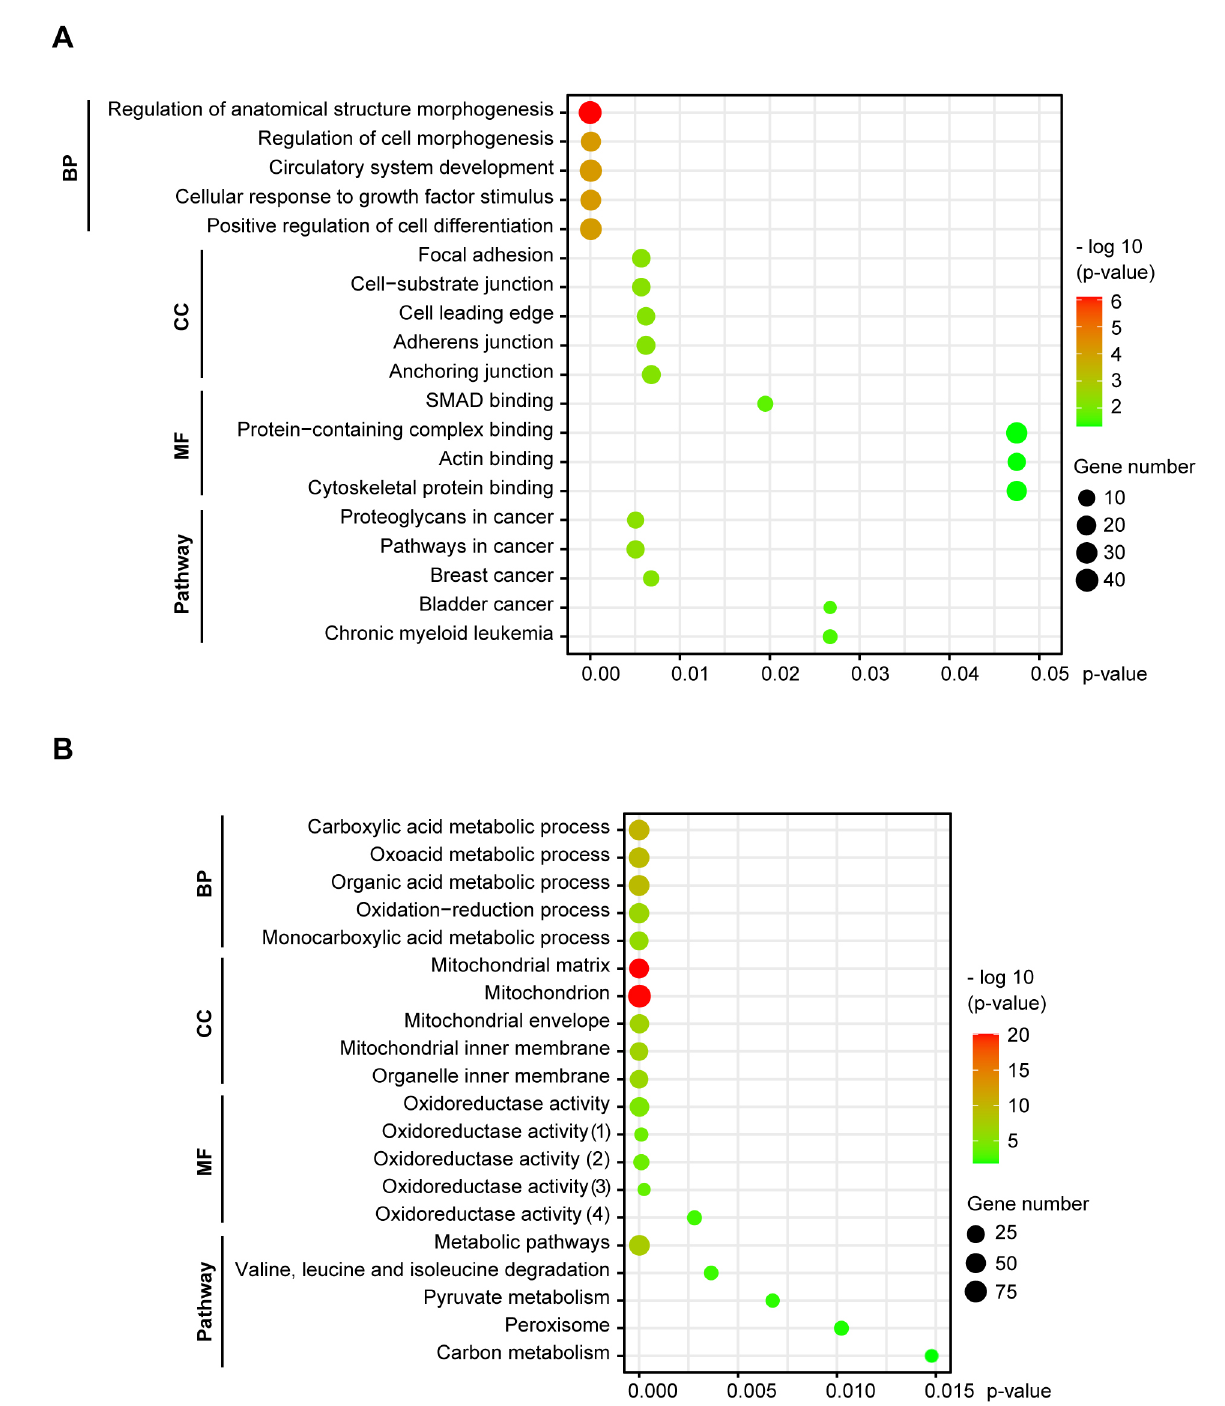
Figure 2. GO functional and KEGG pathway enrichment of DEGs in NSCLC cells undergoing EMT. Functional enrichment of DEGs was categorized into three groups of GO terms: biological process (BP), cellular component (CC) and molecular function (MF). The significance threshold was set to p < 0.05, corrected by BH FDR. ( A ) The upregulated genes were involved in morphogenesis, cell adhesions, SMAD and cytoskeleton binding, and associated with cancer pathways. ( B ) The downregulated genes were linked with metabolic processes, the mitochondrion, oxidoreductase activity and metabolic pathways. (1) Acting on a sulfur group of donors, NAD(P) as acceptor; (2) Acting on NAD(P)H; (3) Acting on the aldehyde or oxo group of donors, disulfide as acceptor; (4) Acting on a sulfur group of